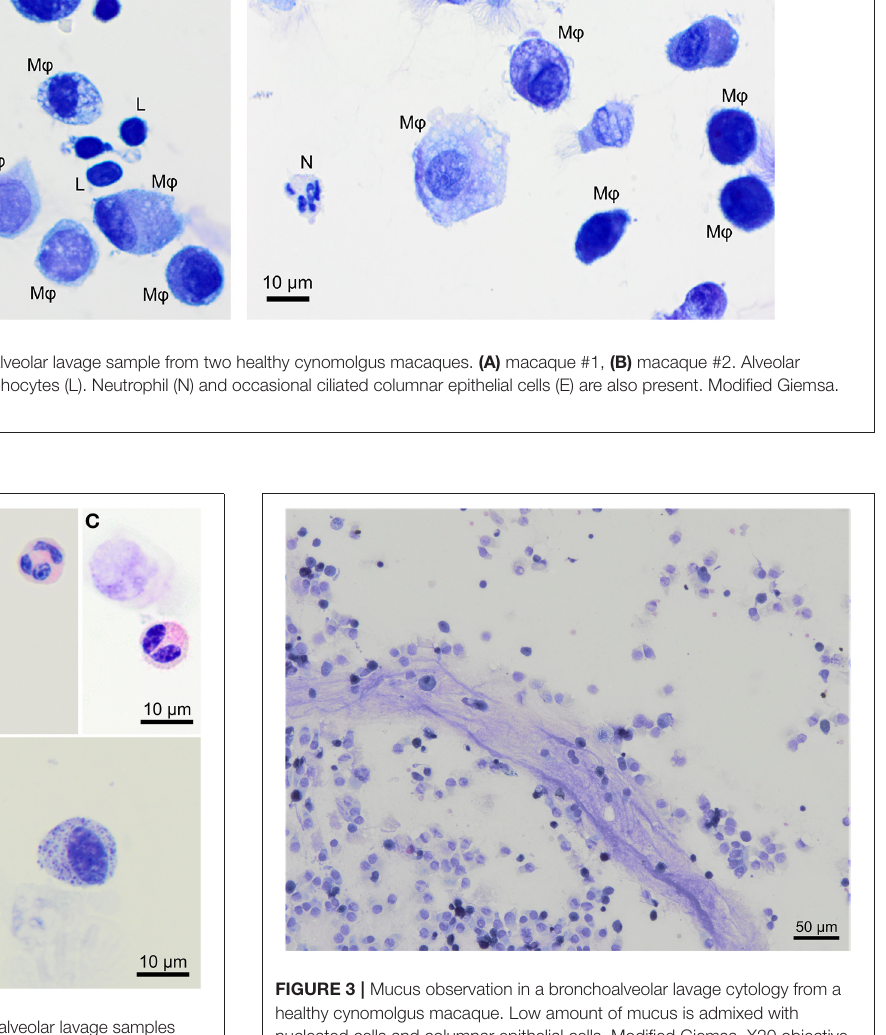
FIGURE 2 | Morphology of cells found in bronchoalveolar lavage samples from healthy cynomolgus macaques. (A) Macrophages, one of them contains a pollen grain (arrow). (B) One lymphocyte (bottom left) and one eosinophil (upper right). (C) Bilobed eosinophil (bottom). (D) One well-preserved neutrophil (bottom left) and a macrophage (upper right). (E) Mast cell. Modified Giemsa. X100 objective. Oil immersion.